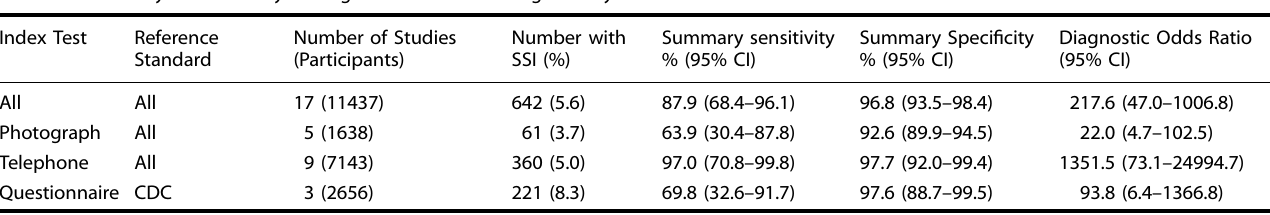
Fig. 4 Coupled forest plot presenting sensitivity and speci fi city of SSI diagnosis by telemedical methods. Final two columns display the sensitivity and speci fi city respectively with 95% con fi dence intervals. Table 2. Summary test accuracy of surgical site infection diagnosis by index test